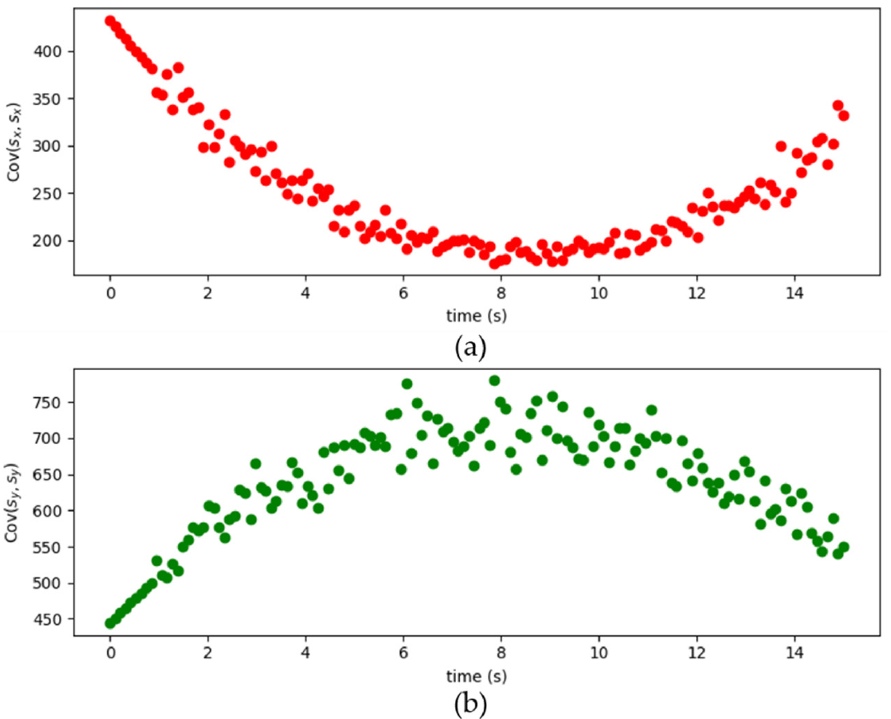
Figure 10. The ( a ) Cov ( s x , s x ) and ( b ) Cov ( s y , s y ) in the Q 2 matrix.